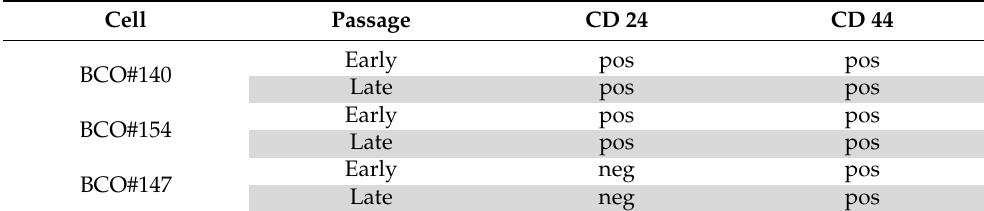
Table 5. Expression of stem-cell markers in paraffin sections of BC organoids 5 . Cell